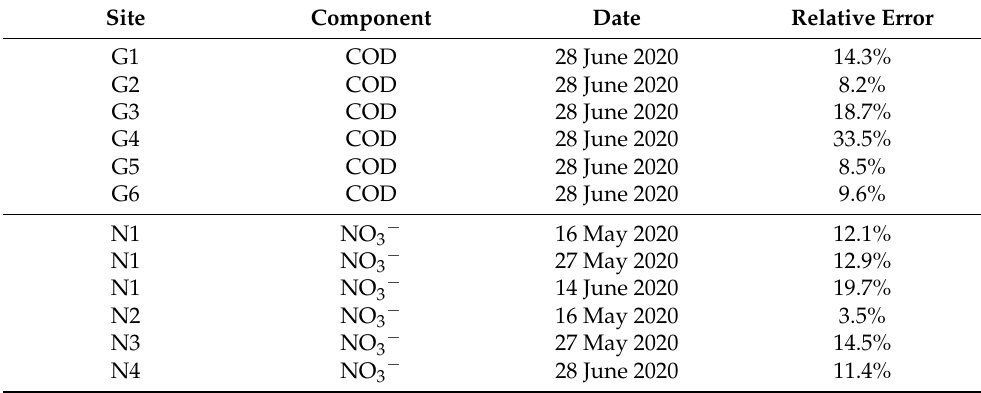
Table 2. Relative errors between the observed data and the simulated results.